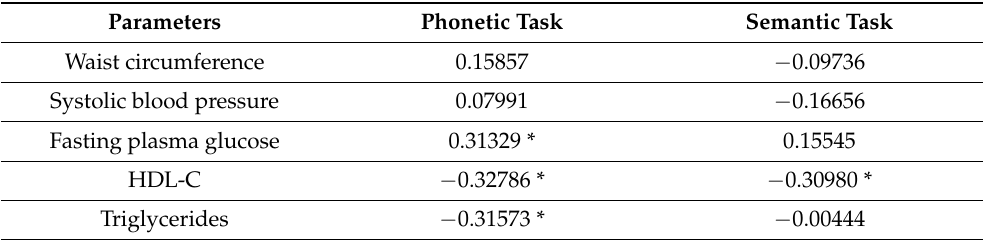
Table 4. Spearman’s correlation coefficient between the phonetic and semantic fluency tasks, and the medical parameters significant for metabolic syndrome diagnosis. Parameters Phonetic Task Semantic Task Waist circumference 0.15857 − 0.09736 Systolic blood pressure 0.07991 − 0.16656 Fasting plasma glucose 0.31329